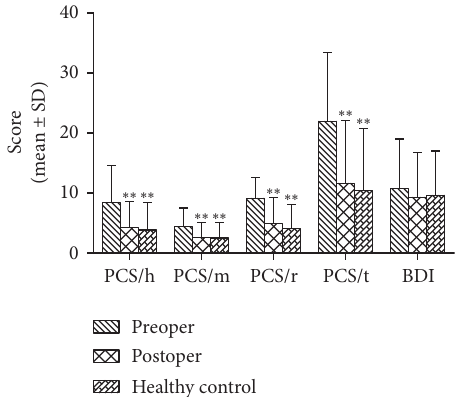
Figure 5: The scores of PCS (helplessness, magnification, rumi- nation, and total) and BDI of the patients who underwent “U” route PELD and healthy individuals. PCS in the patients were evaluated at preoperation and postoperative 2-year follow-up, and the healthy individuals did not experience chronic pain and were age- and sex-matched with the patients. The postoperative PCS scores were all statistically decreased at postoperative 2-year follow-up compared with preoperation (PCS/h p < 0 . 001; PCS/m p < 0 . 001; PCS/r p < 0 . 001; PCS/t p < 0 . 001). The preoperative PCS score was significantly higher compared with healthy individuals (PCS/h p < 0 . 001; PCS/m p < 0 . 001; PCS/r p < 0 . 001; PCS/t p < 0 . 001), but no significance was found of PCS between patients at postoperation and healthy controls (PCS/h p � 0 . 628; PCS/m p � 0 . 923; PCS/r p � 0 . 216; PCS/t p � 0 . 462), and no significant difference of BDI between the patients and healthy individuals either at pre- or